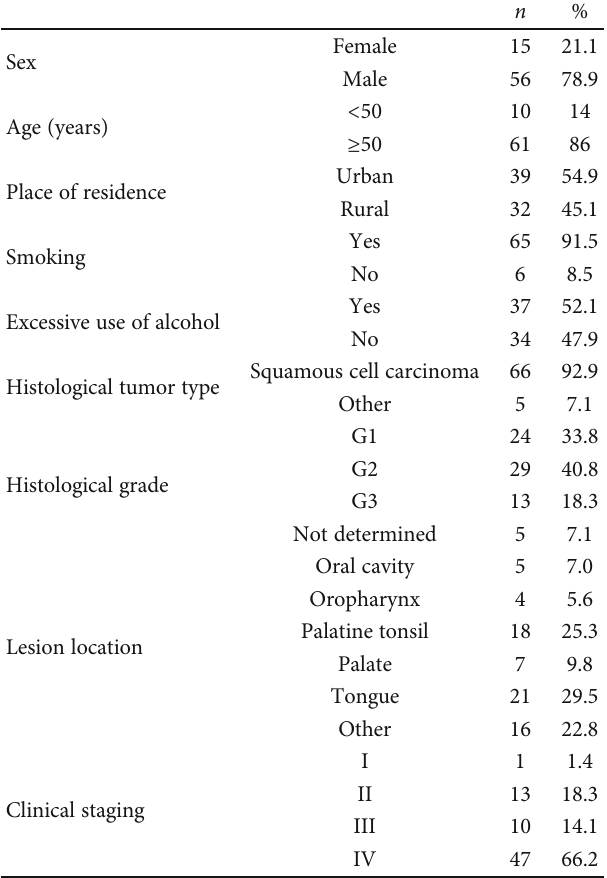
Table 1: Characteristics of the study